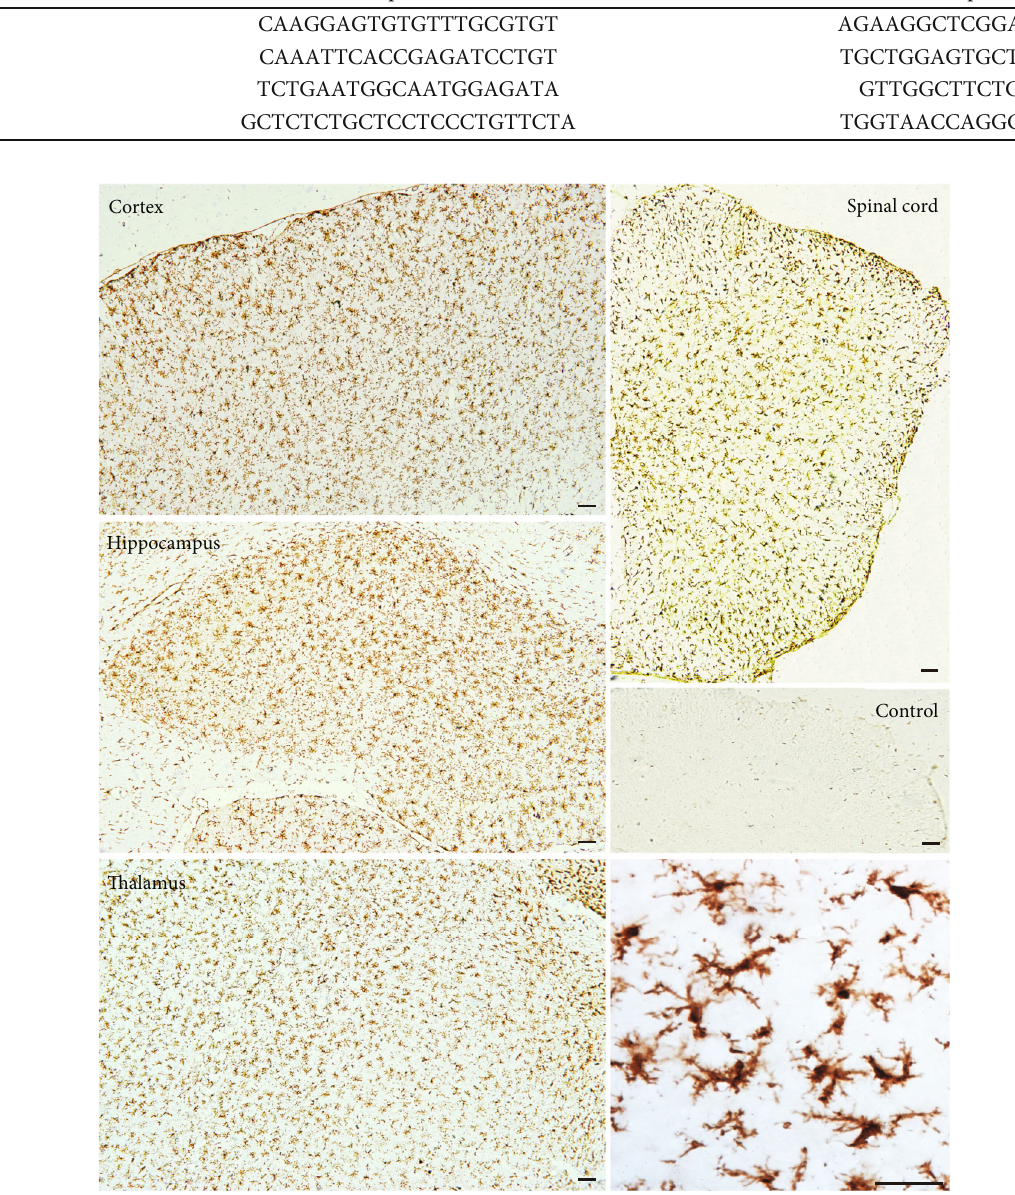
Figure 1: Overall pattern of ANXA3 immunoreactivity in the CNS of rats. Representative immunohistochemical images showing the immunoreactivity of ANXA3 in the cortex, hippocampus, thalamus, and spinal cord and the negative control. The negative control was the cortex tissue that was performed with IHC without a primary antibody. The image in the lower right corner shows the morphology of ANXA3-positive cells in the thalamus at a higher magni fi cation. Scale bar = 100 μ m